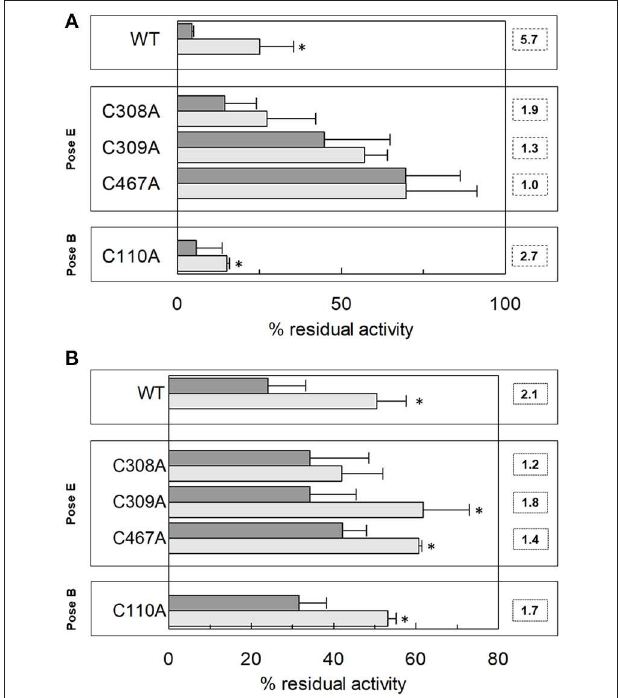
FIGURE 9 | Effect of HgCl 2 and NEM on transport activity of hASCT2 WT and Cys mutants reconstituted in proteoliposomes. Effect of HgCl 2 (A) or NEM (B) . Purified hASCT2 WT, C308A, C309, C467A or C110A was reconstituted in proteoliposomes prepared without CHEMS (dark gray bars) or with 75 µ g/mg phospholipids CHEMS (light gray bars) as described in Materials and Methods. Transport was started by adding 50 µ M [ 3 H]glutamine and 50mM Na-Gluconate in the presence of 20 µ M HgCl 2 (A) or 0.5mM NEM (B) , to proteoliposomes containing 10mM glutamine. Transport was measured in 20min. The boxes grouped the residues corresponding to the indicated poses (see Figure 6 ). Dotted boxes indicated the protection index calculated as the ratio between residual activity in the presence of CHEMS and the residual activity in the absence of CHEMS. Transport activity was calculated as the percent of residual activity with respect to the control condition (without any addition in the transport assay). *Significantly different from the control sample (proteoliposomes prepared without CHEMS) as estimated by Student’s t -test ( P < 0.05). Data are means ± SD of three independent experiments.